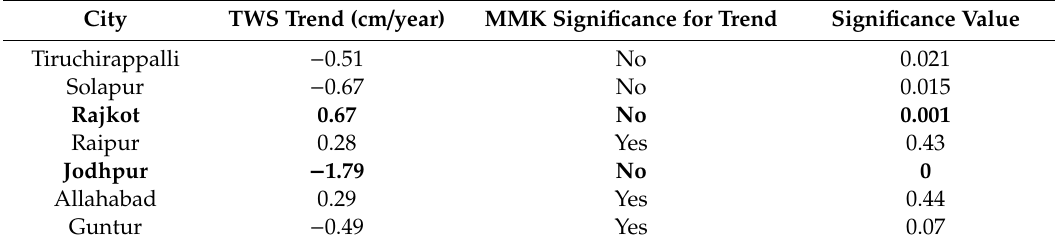
Figure 7. Terrestrial Water Storage (TWS) changes with respect to time in the cities with the high increasing (Rajkot) and decreasing (Jodhpur) GWL trends. Table 2. Magnitude of TWS trend based on the Theil-Sen slope and significance of trend based on the MMK